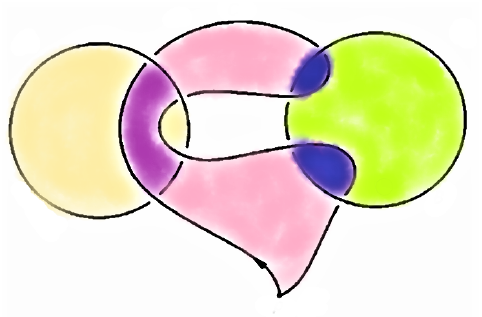
Figure 3. Encoding of the Borromean link by the group commutator of the generators of Θ 2 .